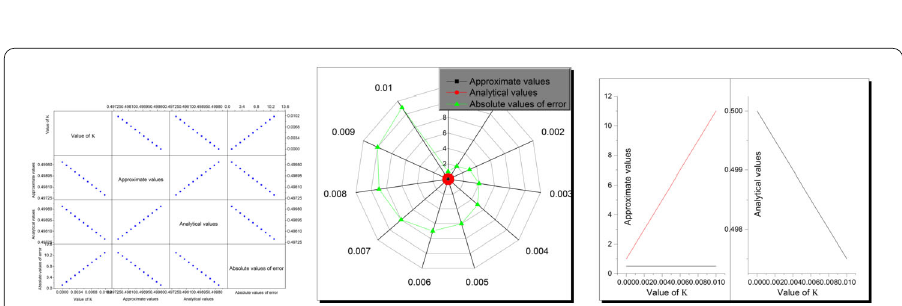
Figure 5 A comparison representation between analytical and numerical solutions of Eq. (1) according to the septic-B-spline simulation